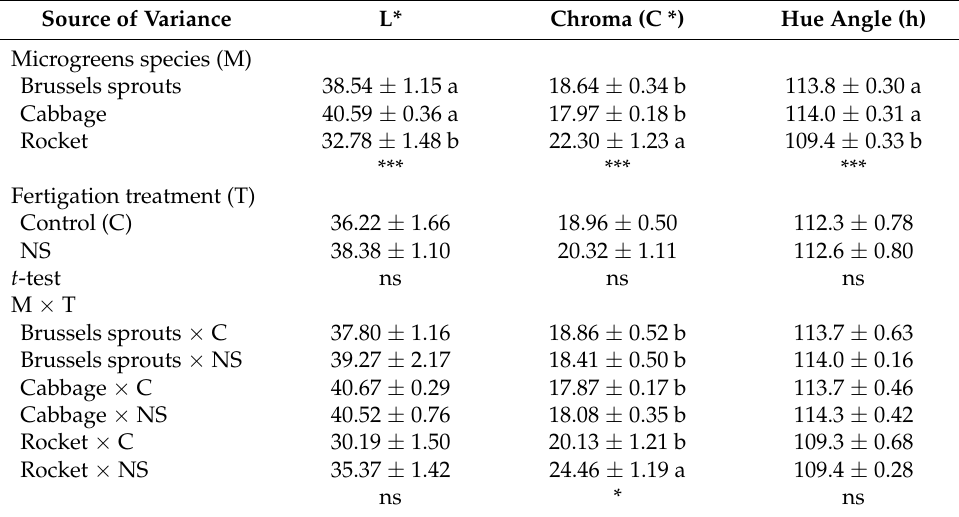
Table 1. Microgreens canopy CIELAB color space parameters (L*), chroma and hue angle in light of the nutrient solution